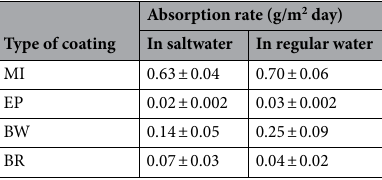
Table 8. The average absorption rate for the different coating materials in salt and regular water.